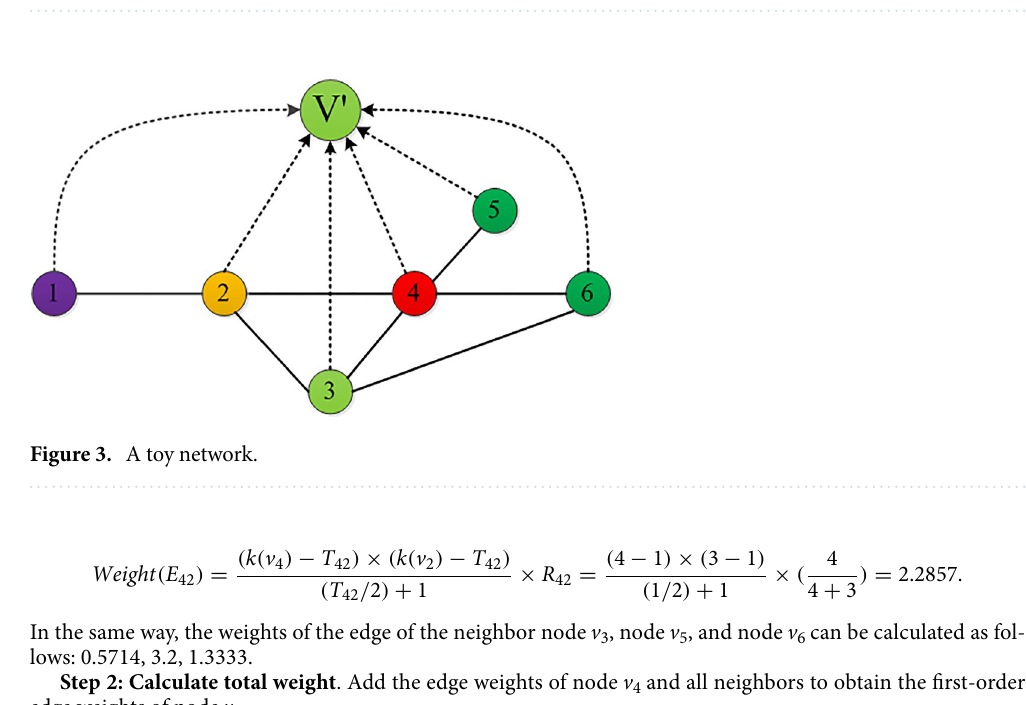
Table 1. Time complexity of different algorithms. ( n , m and r represent the number of nodes, edges and initial infected nodes, respectively.)